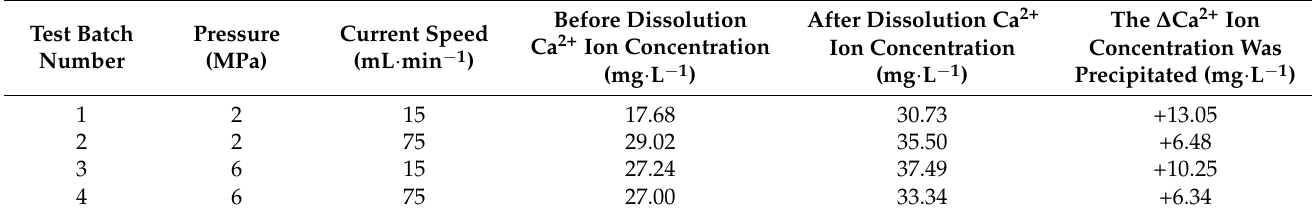
Table 6. Solution Ca 2+ concentration data under four groups of test